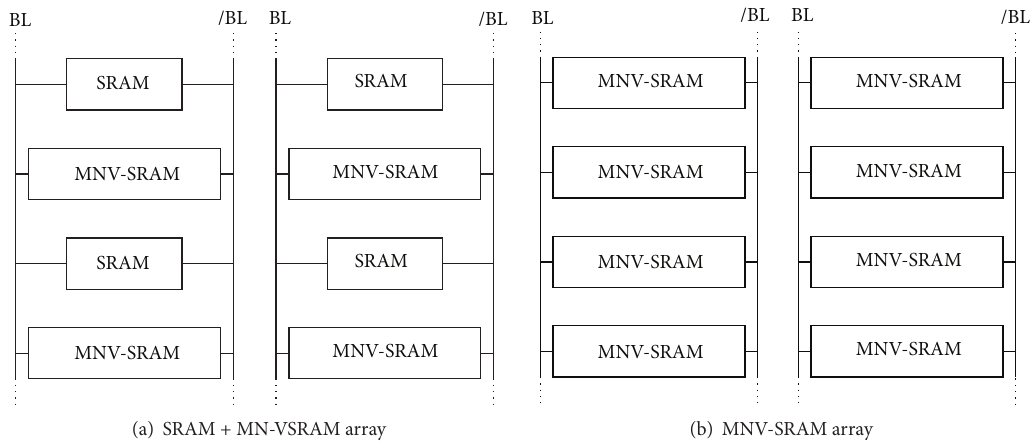
Figure 2: Array structure. (a) Half of the array is SRAM. (b) All of the array is